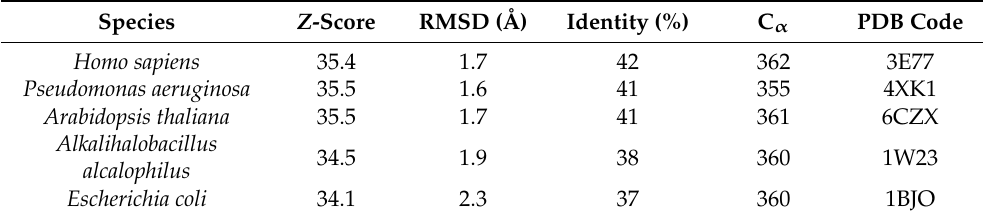
Table 1. Structural similarity between Sc PSAT and its homologs, compared using Dali a . Species Z -Score RMSD (Å) Identity (%) C α PDB Code Homo sapiens 35.4 Pseudomonas aeruginosa 35.5 Arabidopsis